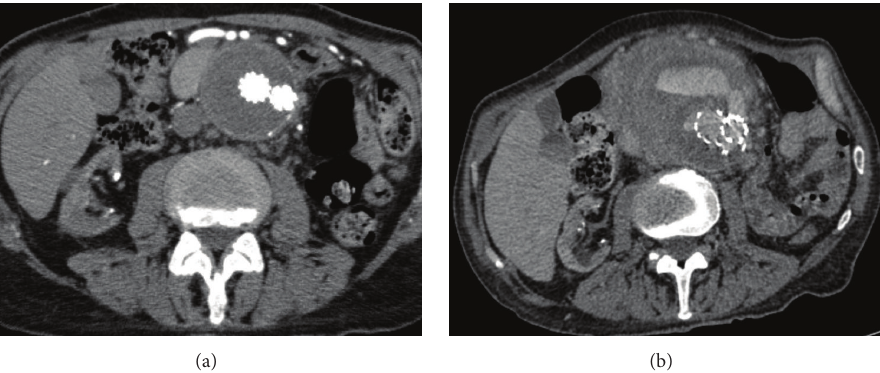
Figure 1: (a) 12-month follow-up CT scan indicating complete exclusion of the aneurysm with sac shrinkage after the initial procedure. (b) CT angiography showing enlarged AAA with hematoma and endoleak originating from distal main body of the EVAR graft.